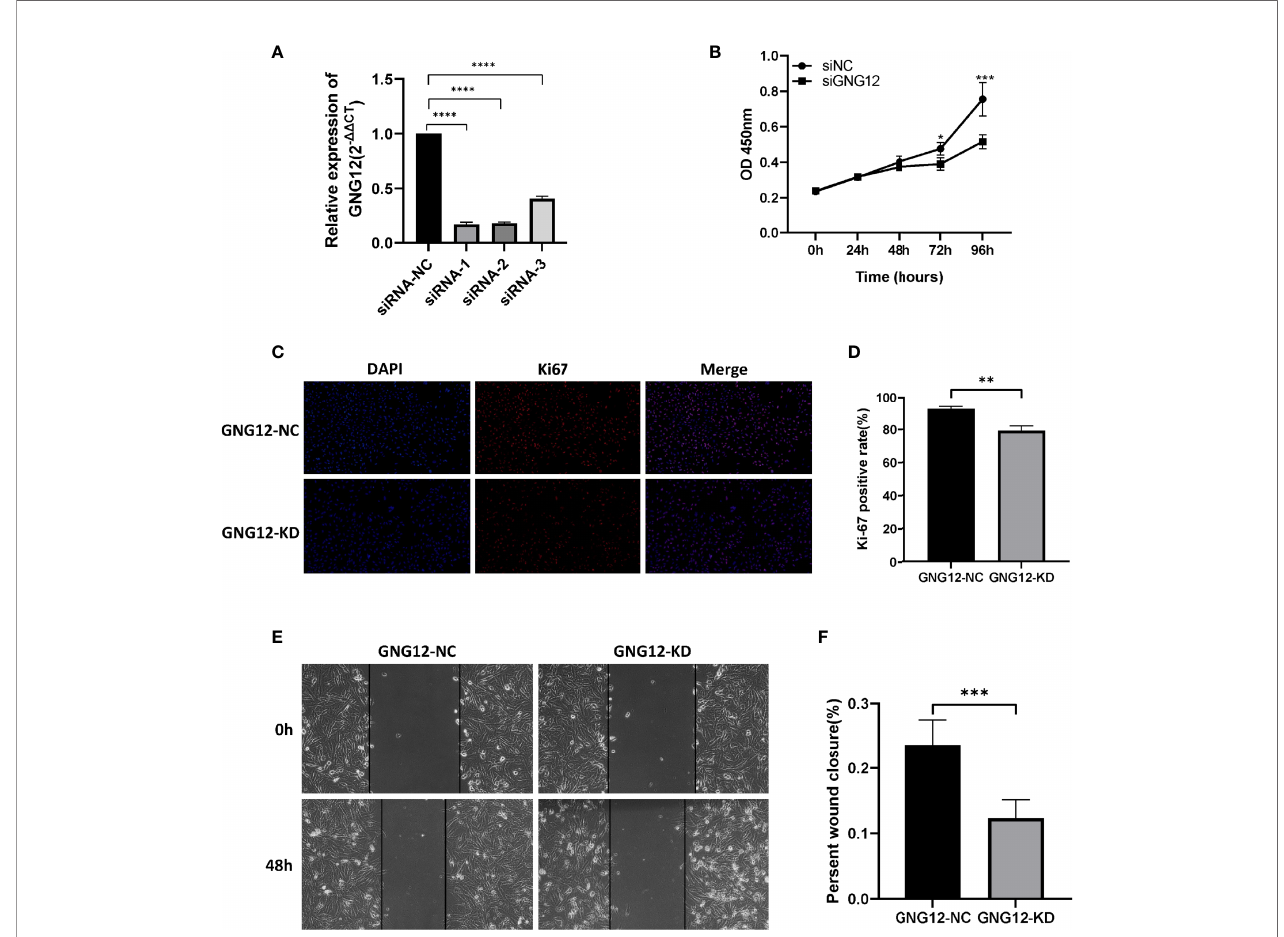
FIGURE 6 | Effects on proliferation and migration of glioma cells by down-regulating GNG12 expression levels. (A) Detection of knockdown ef fi ciency of different siRNA sequences in the glioma cell line LN229. (B) CCK-8 assay to compare the effect on cell proliferation after down-regulation of GNG12. (C) Immuno fl uorescence assay comparing the positive rate of Ki-67 after transfection with siRNA-NC and siRNA-KD (Magni fi cation: *400). (D) Immuno fl uorescence assay to analyze the results. (E) Cell scratch healing assay using LN229 cell line to compare the migration distance between GNG12-NC group and GNG12-KD group (Magni fi cation: *200). (F) Results of statistical analysis of cell scratching experiments. (****P<0.0001, ***P<0.001, **P<0.01,